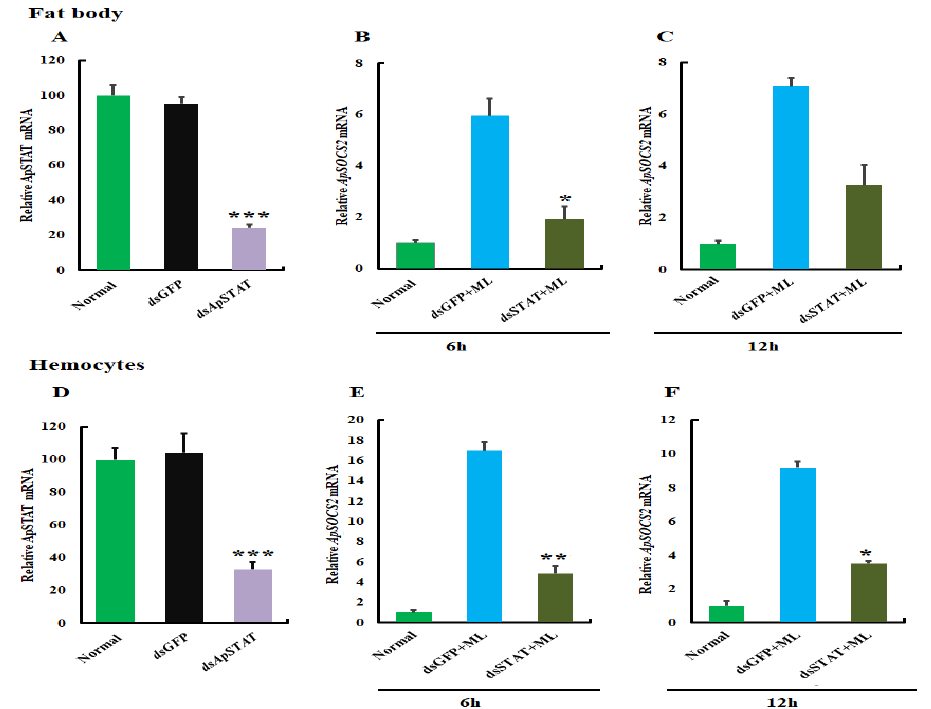
Figure 9. ApStat regulates ApSOCS-2 expression in silkworm challenged with M. luteus at 6 and 12 h normalized to 18 S and actin-1 (Actin-1 normalized: Figure S7). The efficiency of ApStat -RNAi in fat bodies ( A ) and hemocytes ( D ). ( C , D ) After dsApStat injection, the ApSOCS-2 expression in fat bodies of silkworm challenged with M. luteus at 6 ( B ) and 12 h ( C ) was detected by qRT-PCR in fat bodies. Following dsApStat injection, the ApSOCS-2 expression in hemocytes of silkworm challenged with M. luteus at 6 ( E ) and 12 h ( F ) was detected by qRT-PCR. The GFP-RNAi was used as the control. Asterisks indicate significant differences (* p < 0.05, ** p < 0.01, *** p < 0.001).